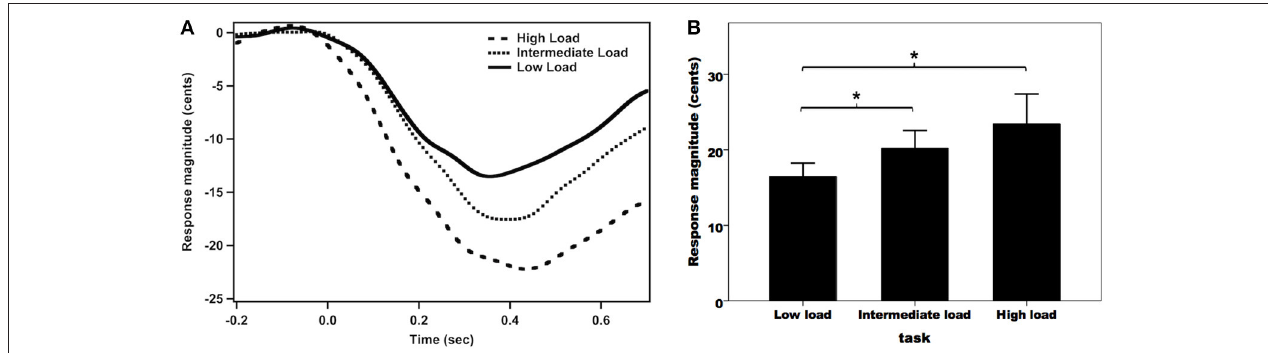
FIGURE 2 | Grand-averaged voice F 0 contours (A) and T-bar graphs of the absolute values of compensatory vocal responses (B) to pitch perturbations across the three attentional loads. The thick solid line, the dense dashed line, and the sparse dashed line represent the vocal responses during the low-load, intermediate-load, and high-load conditions of divided attention, respectively. The asterisks represent significant differences between the load conditions.